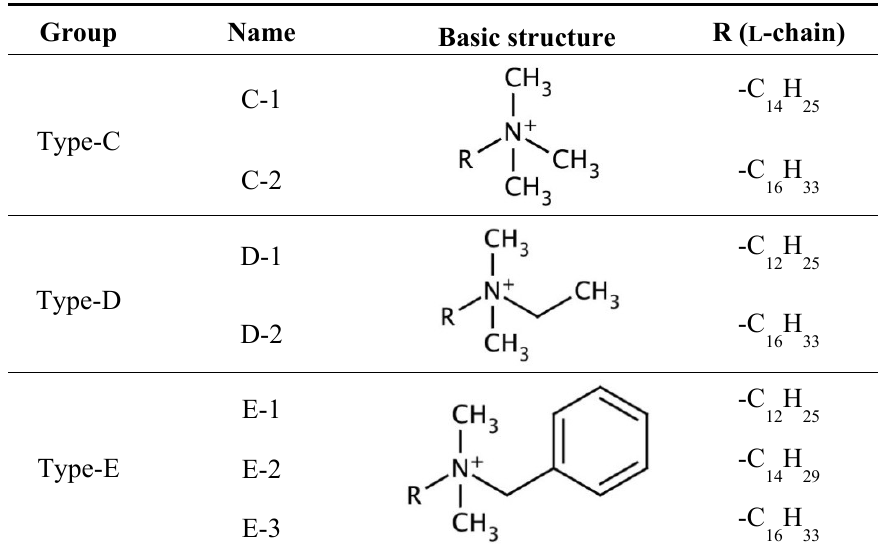
Table 1. Structures of the mono-cationic detergents